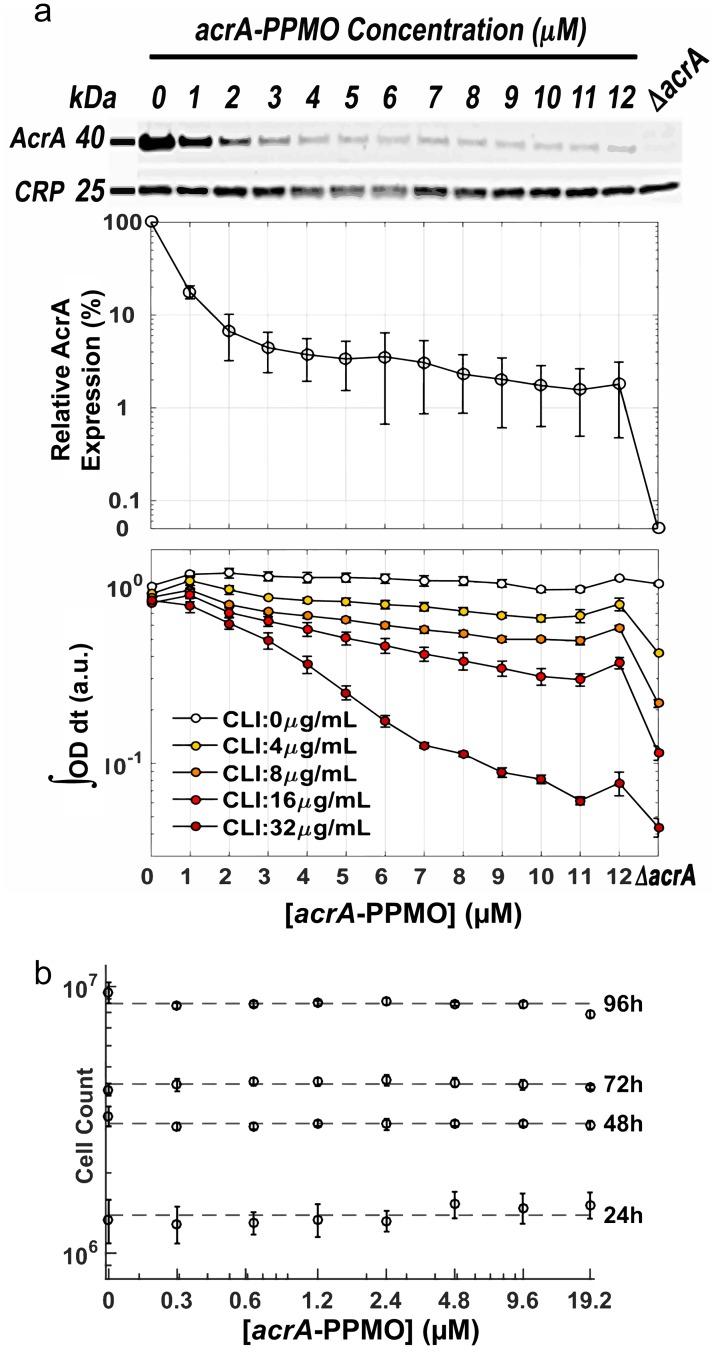
acrA-PPMO blocks acrA translation in a dose-dependent fashion and is nontoxic to HBEC3KT human cells.(A) AcrA expression in E. coli with increasing concentrations of acrA-PPMO was quantified using an anti-AcrA antibody (top panel). AcrA expression was normalized against the expression of cAMP receptor protein (CRP). Error bars represent the standard deviations of normalized AcrA protein levels for six experimental replicates (middle panel). E. coli growth in fixed concentrations of clindamycin with increasing concentrations of acrA-PPMO is calculated by calculating the AUC growth in different experimental conditions (bottom panel). Error bars represent the standard deviation of growth rate changes of four experimental replicates. (B) acrA-PPMO has nonsignificant levels of toxicity to HBEC3KT human cells. HBEC3KT human cells were incubated with increasing doses of acrA-PPMO, and the number of viable cells was determined (Cell-Titer-Glo, Promega) every 24 h for 4 d. Error bars represent the standard deviation of cell counts obtained from ten replicate experiments.